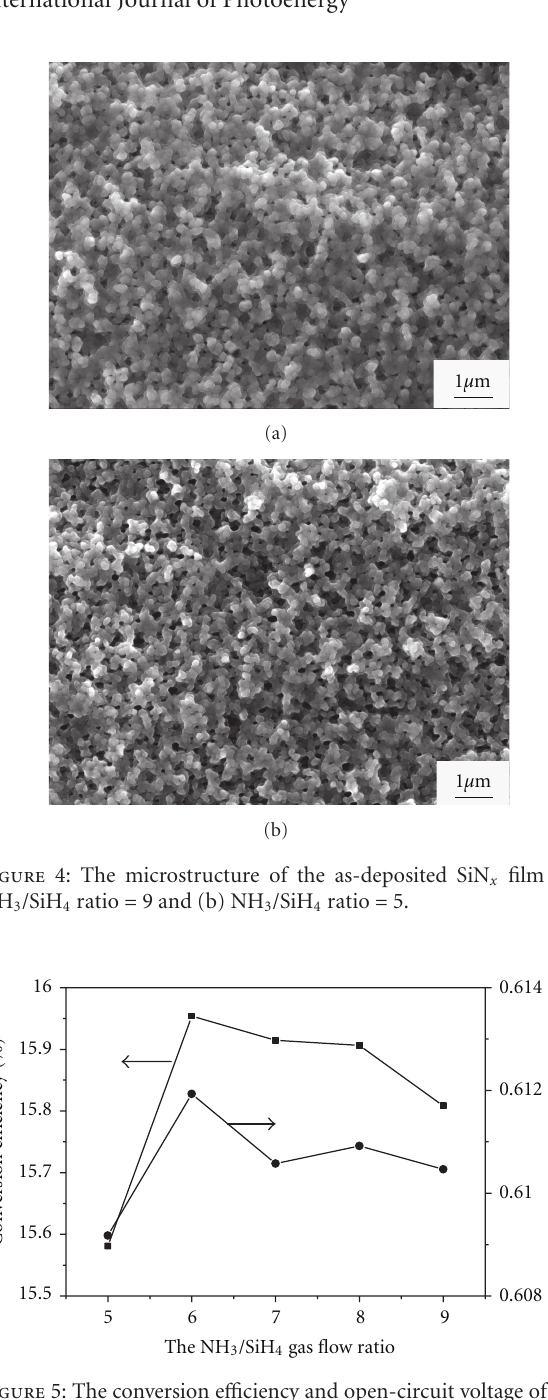
Figure 5: The conversion e ffi ciency and open-circuit voltage of the black silicon solar cell varying with the NH 3 /SiH 4 gas flow ratio.